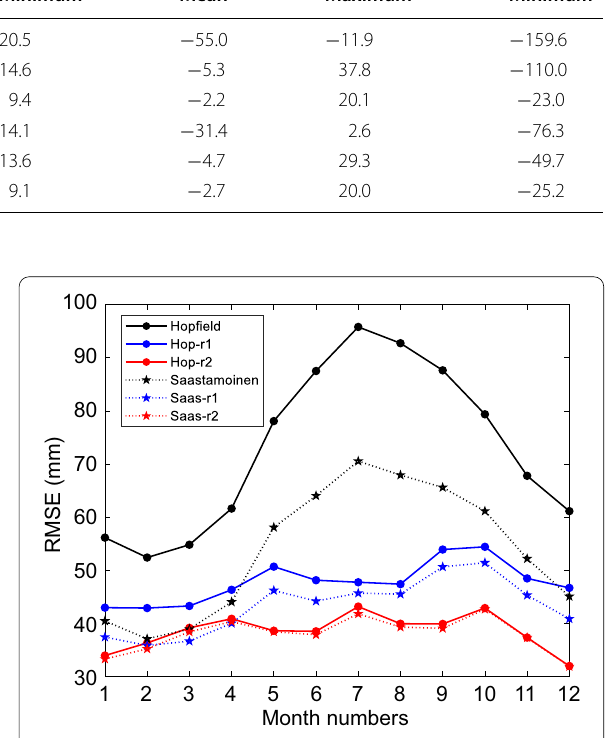
Fig. 6 Monthly mean RMSE of the stations for six models